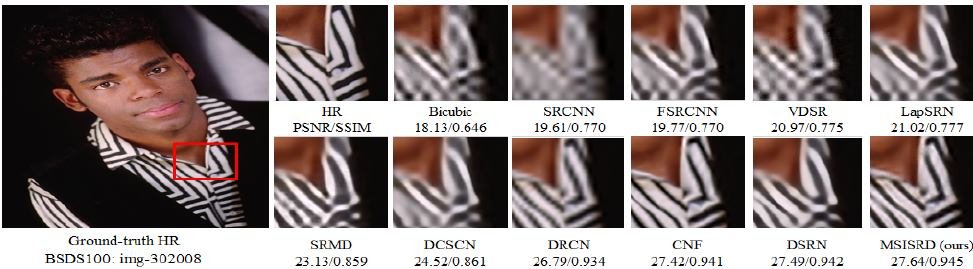
Figure 11. Visual performance of the image “302008” from BSDS100 [58] dataset with 8 × scale factor enlargements [71].